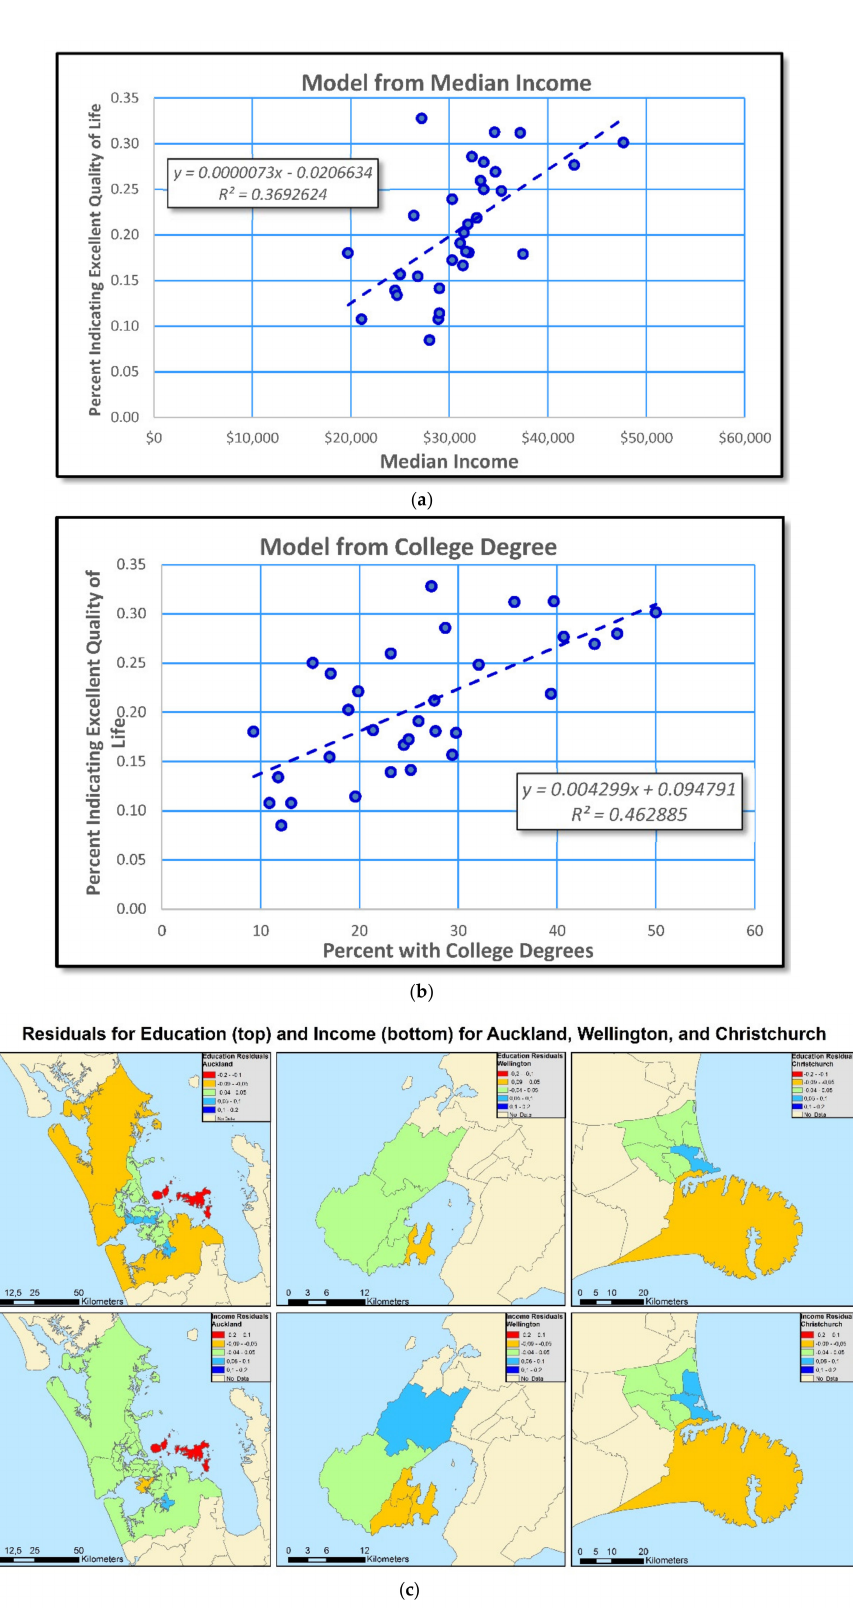
Figure 2. Regression results between excellent QoUL and predictive variables of education and degree ( a ) Observed values for perceived excellent QoUL and annual median income. ( b ) Observed values for perceived QoUL and percent with university degree. ( c ) Mapped residuals for education and income for Auckland, Wellington, and